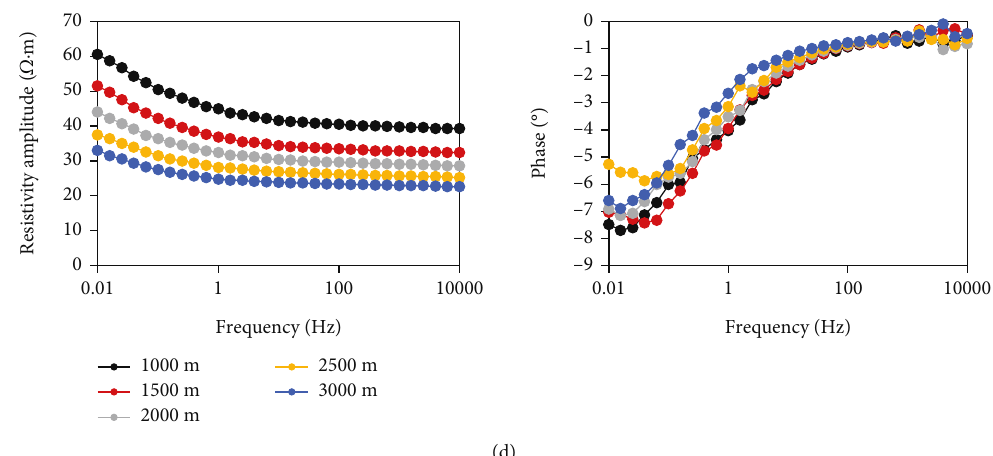
Figure 7: (a – d) The amplitude and phase curves of the complex resistivities of samples 1, 2, 3, and 5 under di ff erent simulated formation depths, respectively. The left column shows the complex resistivity amplitude curves, and the right column shows the complex resistivity phase curves.